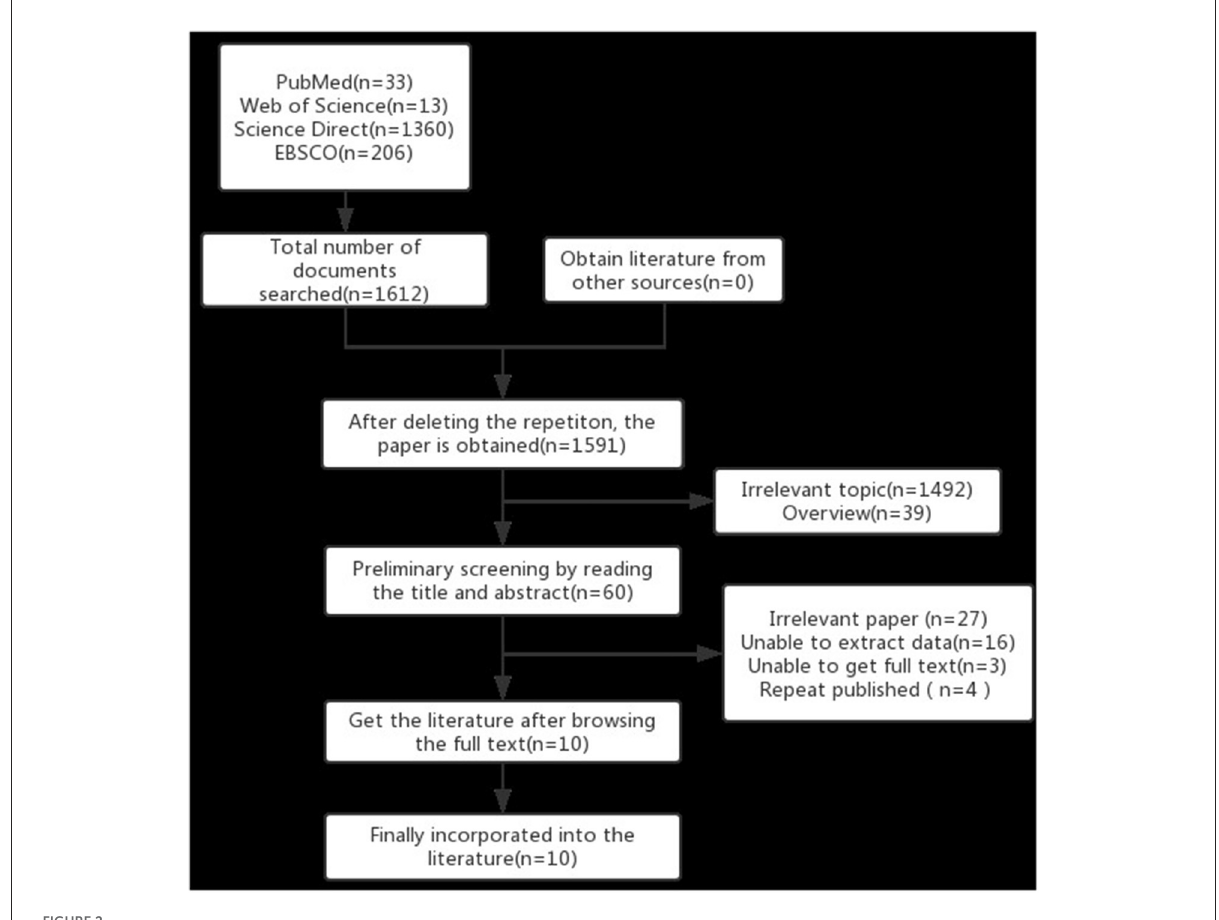
FIGURE2 Literature screening